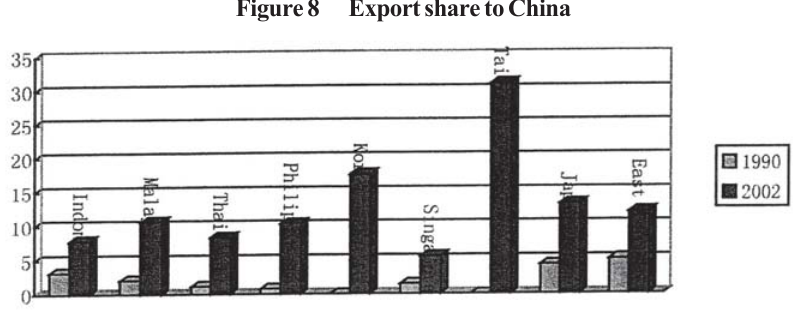
Note: The share represents the export percentage to China in its total export. 2001 figure